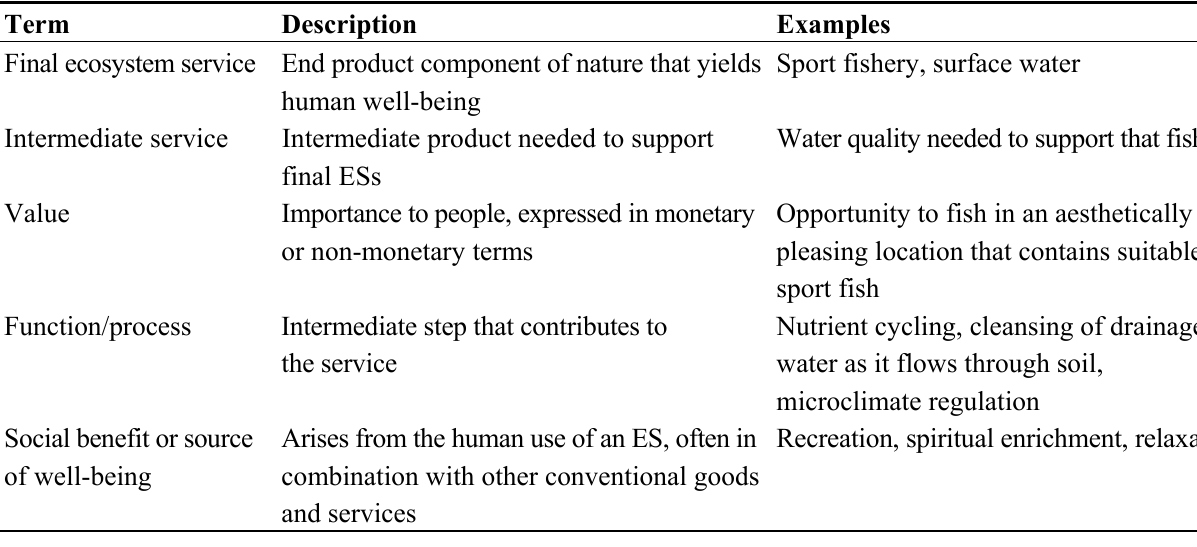
Table 1. Some key terms that are central to the ecosystem service concept based on the example of acidification effects on recreational